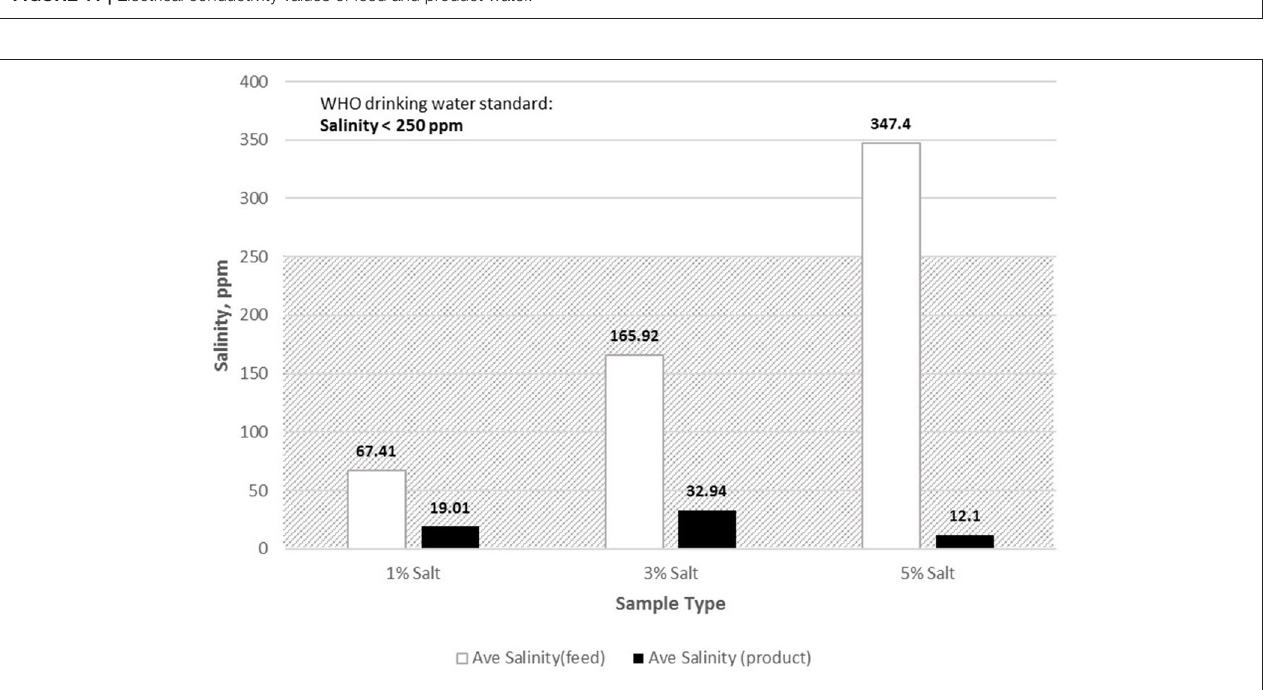
FIGURE 12 | Salinity values of feed and product